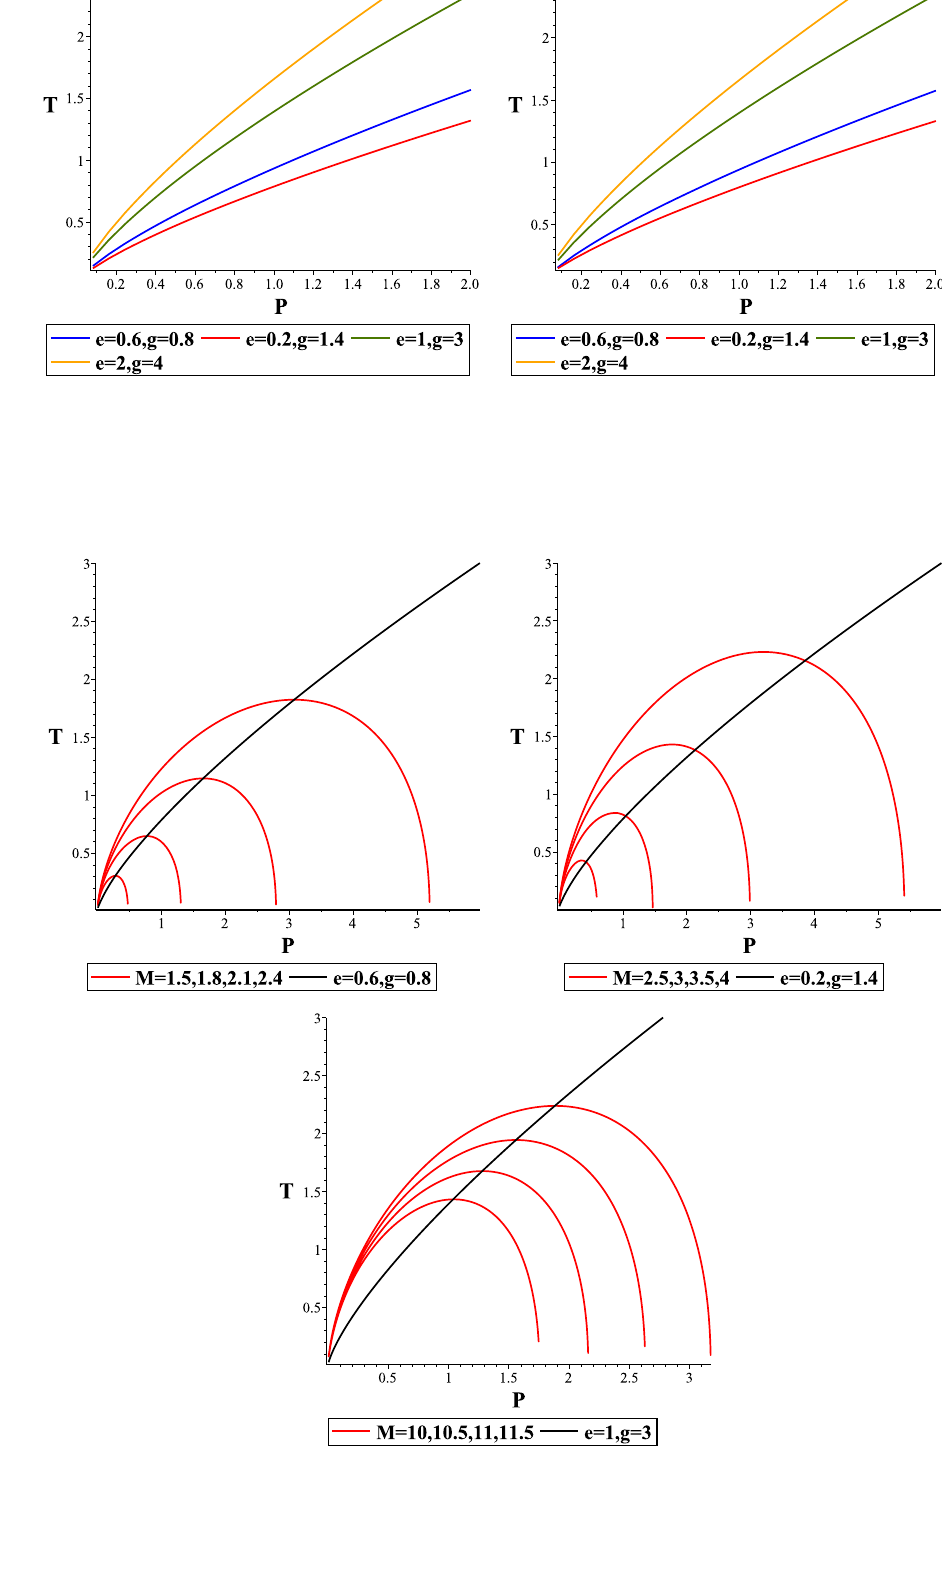
Fig. 4 Inversion curves for dynamic phantom AdS BH. Left Panel: a 2 = 1 and right panel: a 2 = 2